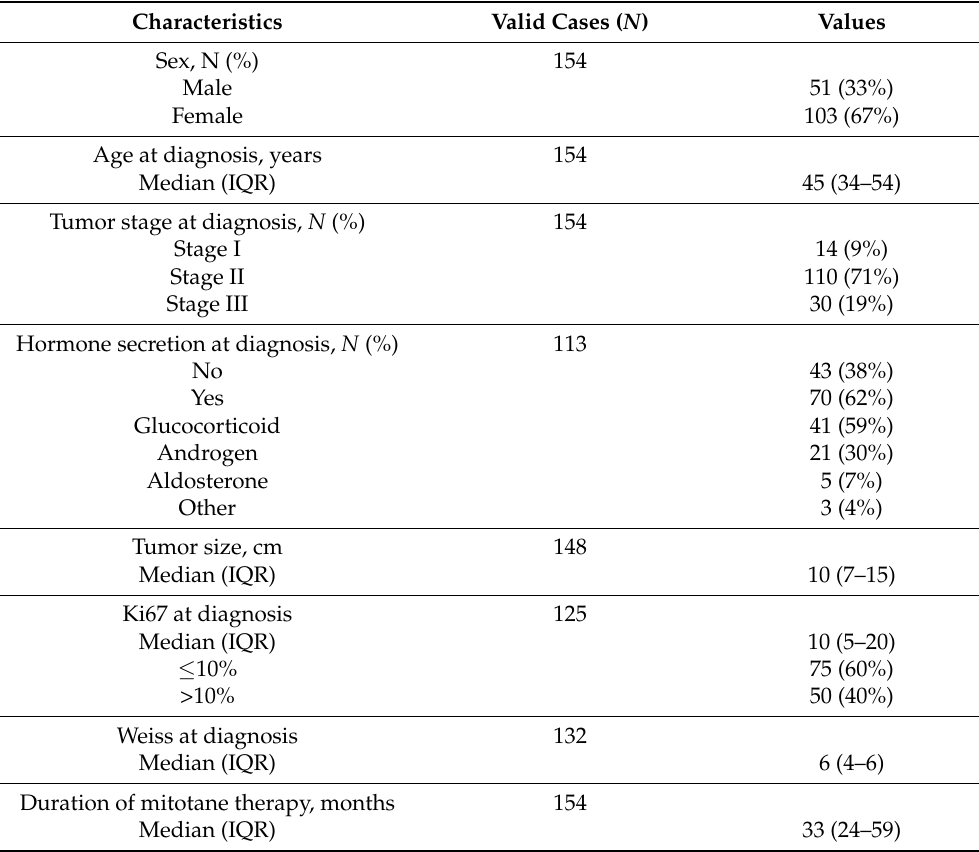
Table 1. Baseline characteristics of